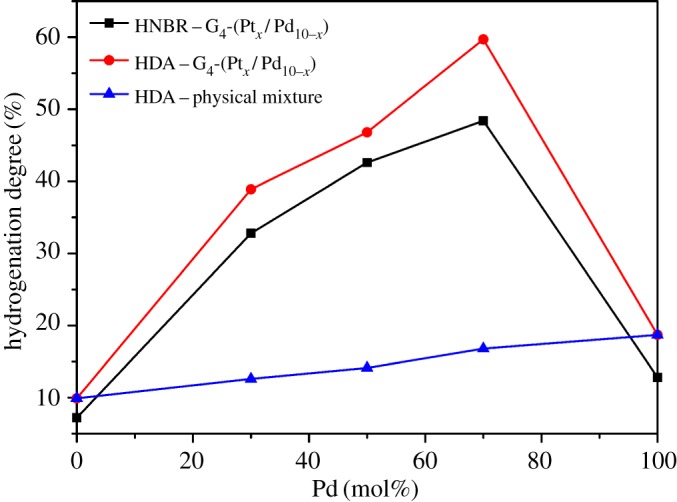
The effects of mole percentages of Pd in G4M-(Ptx/Pd10−x) (x = 0, 3, 5, 7, 10) on the HD of HDA and HNBR. The effects of mole percentages of Pd in the physical mixture of G4M-Pt and G4M-Pd on the HD of HDA.